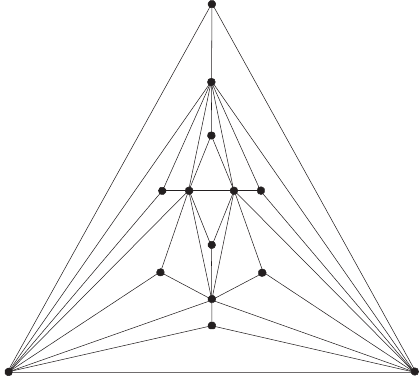
Fig. 1: A connected nontraceable LH graph of order